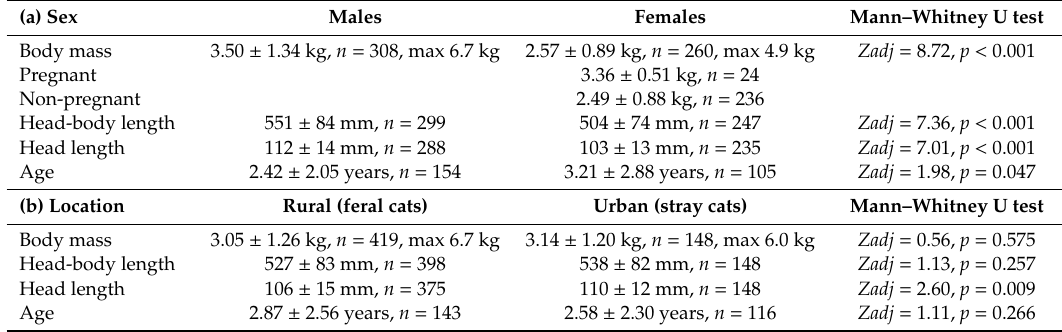
Table 1. Demographics and significance testing for stray and feral cats ( Felis catus ) presented by (a) sex and (b) source location in southwest Western